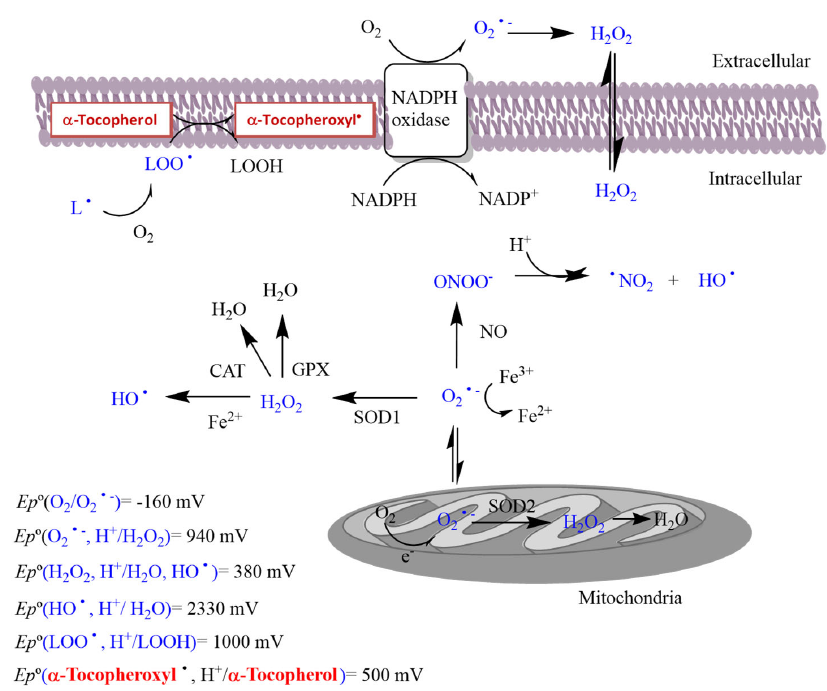
Figure 1. Reactive oxygen and nitrogen species (ROS and RNS) generation within a cell, and standard redox potentials (pH = 7) for the redox couples involved in the formation of some ROS, and in their inhibition, by radical scavengers [8]. CAT: catalase, SOD: superoxide dismutase, GPX: glutathione peroxidase, NADPH oxidase: nicotinamide adenine dinucleotide phosphate